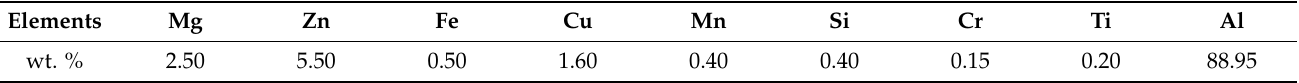
Table 1. Chemical composition of the substrate (Al7075) used for the EL-deposition/coating process. Elements